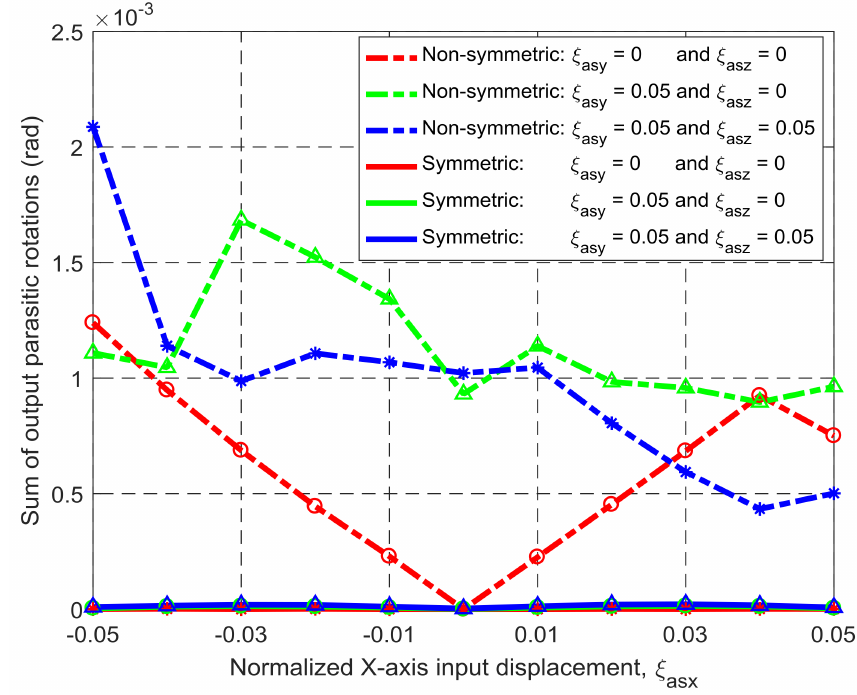
’, in this figure are data points). (cid:35)